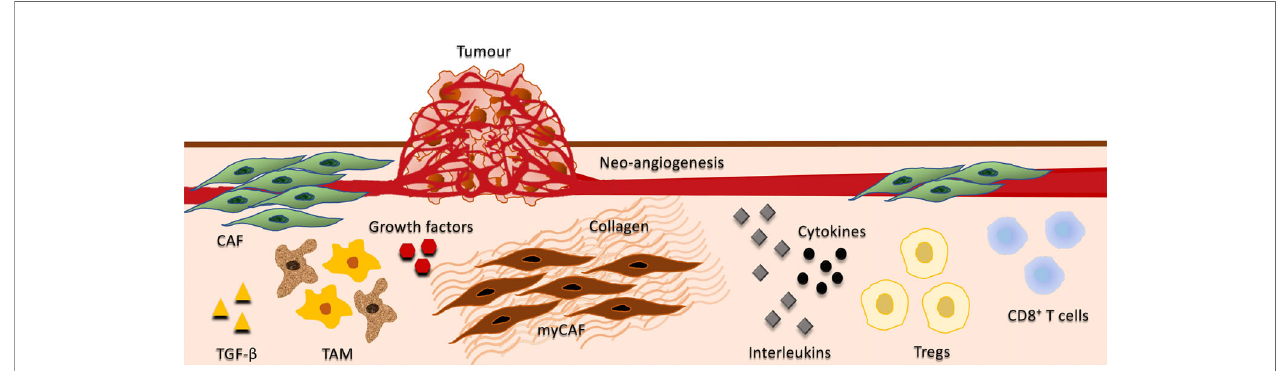
FIGURE 3 | Interplay between tumor, stromal, and immune cells. Depicts the interplay between cancer-associated fi broblasts (CAF), tumor-associated macrophages (TAM), growth factors, cytokines, interleukins, and immune cells in the tumor microenvironment (TME). CAF are the predominant cell type in the tumor stroma, contributing to the proliferative, pro-in fl ammatory, immunosuppressive, angiogenic, pro-invasive and pro-metastatic TME. They secrete various growth factors including TGF- b , vascular endothelial growth factor (VEGF), fi broblast growth factor 5, growth differentiation factor 15, and hepatocyte growth factor. CAF also produce cytokines and interleukins that may have both immunosuppressive and immuno-activating effects on various leukocytes, including CD8 + T cells, immunosuppressive regulatory T cells (T regs ) and macrophages. A subset of CAFs have myo fi broblasts characteristics (myCAF) and play a major role in the development of the fi brotic stroma in the TME including the regulation of collagen fi bre elongation. Growth factors and immunosuppressive cytokines produced by TAM enhance motility, intravasation, and invasion of tumor cells, while stimulating angiogenesis and suppressing T cell in fi ltration. Additionally, TGF ‐ b produced by TAMs activate immunosuppressive T